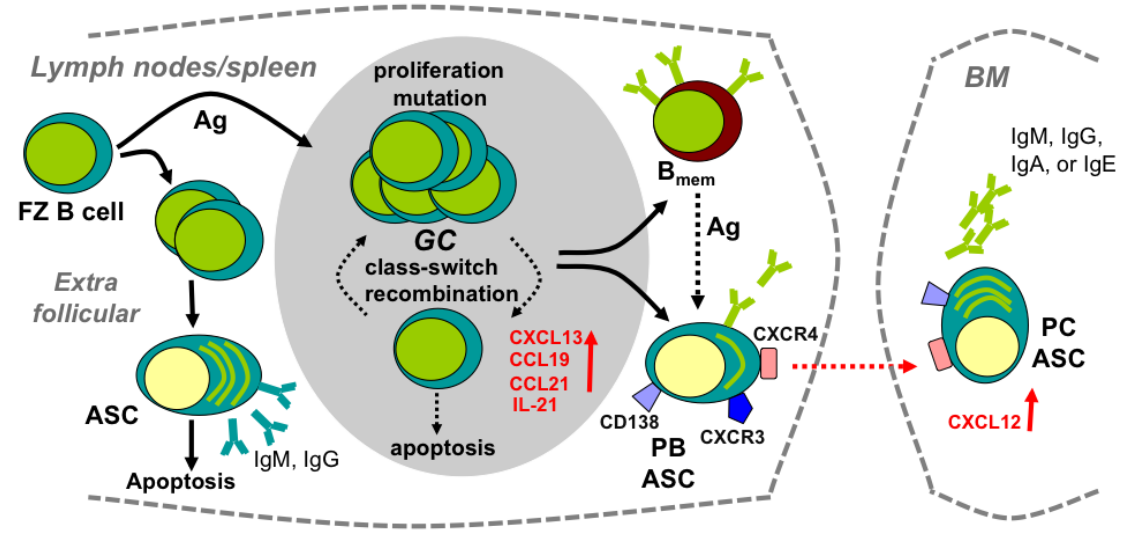
Figure 1. Development of peripheral humoral responses. Follicular zone (FZ) B cells in lymph nodes/spleen encounter antigen (Ag), proliferate and migrate to extrafollicular foci or lymphoid follicles. Extrafollicular B cells differentiate into short-lived antibody secreting cells (ASC), producing low-affinity Ab. B cells migrating to lymphoid follicles form germinal centers (GC) and differentiate into high Ab affinity plasma blasts (PB) and non-Ab-secreting memory B cells (B ). ASC egress into the circulation and give rise to mem long-lived plasma cells (PC) residing primarily in bone marrow (BM). CXCR4–CXCL12 interactions mediate ASC homing to, and retention in,